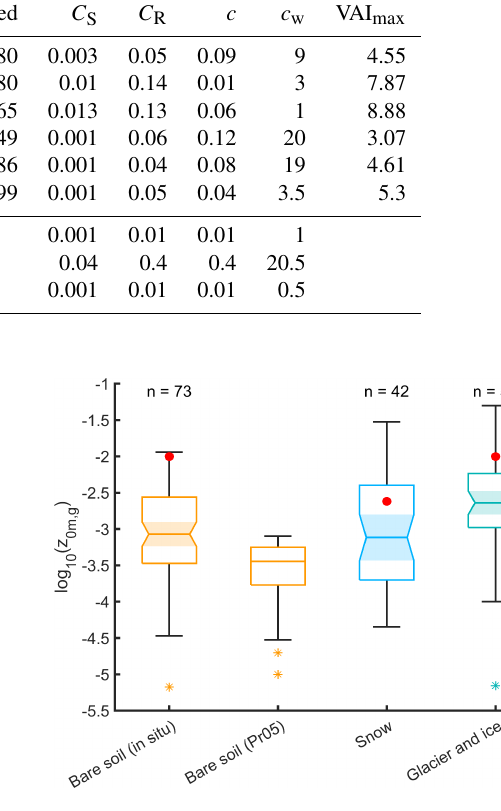
Figure 2. Boxplot of the decimal logarithm in in situ observations of z 0m , b (left), z 0m , s (second from right), and z 0m , i (right). The value of n corresponds to the number of sites. Second boxplot from left shows z 0m , b in remote-sensing-based data of Prigent et al. (2005). Stars correspond to outliers, which are more than 1.5 times the in- terquartile range away from the box. Red dots show the current value in